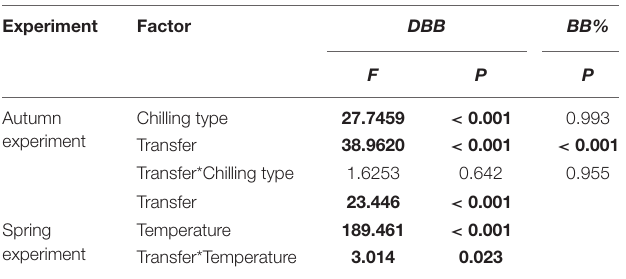
TABLE 1 | Statistical analysis of factors affecting the days to bud burst, DBB, and the bud burst percentage, BB%, in the autumn and spring experiments (BB% in the autumn experiment only).